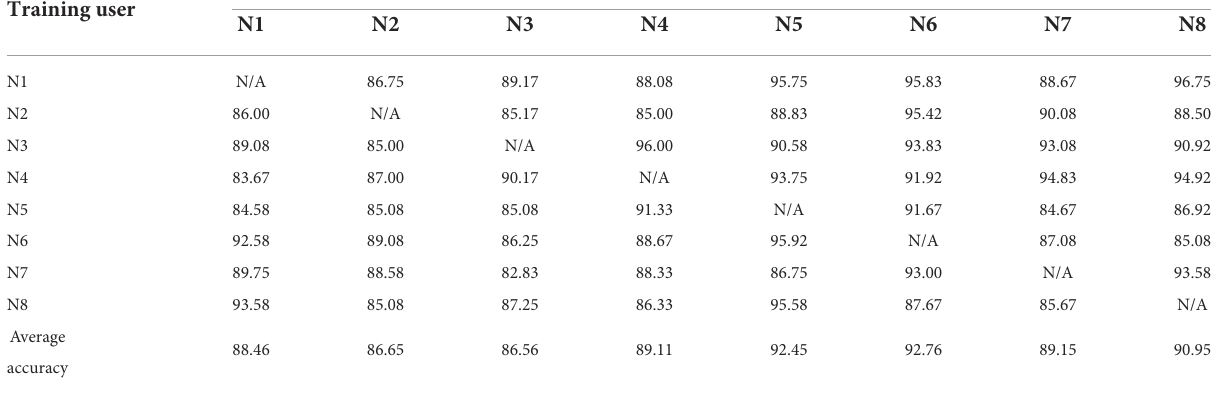
TABLE 3 Experimental results for user-independent CCA-with-ADR